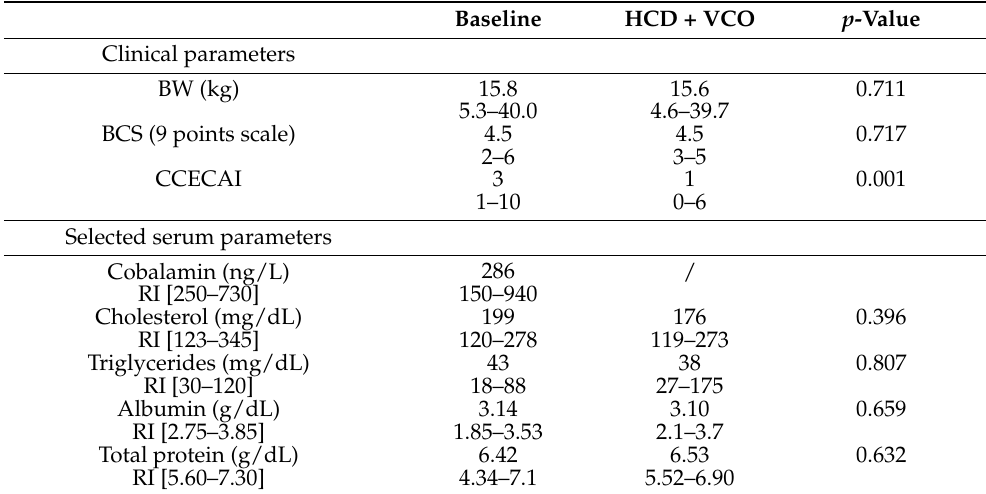
Table 3. Clinical scores, body weight, and selected blood parameters assessed in dogs during the first visit (baseline) and after the addition of virgin coconut oil to the home-cooked diet (HCD + VCO). Data are expressed as median and